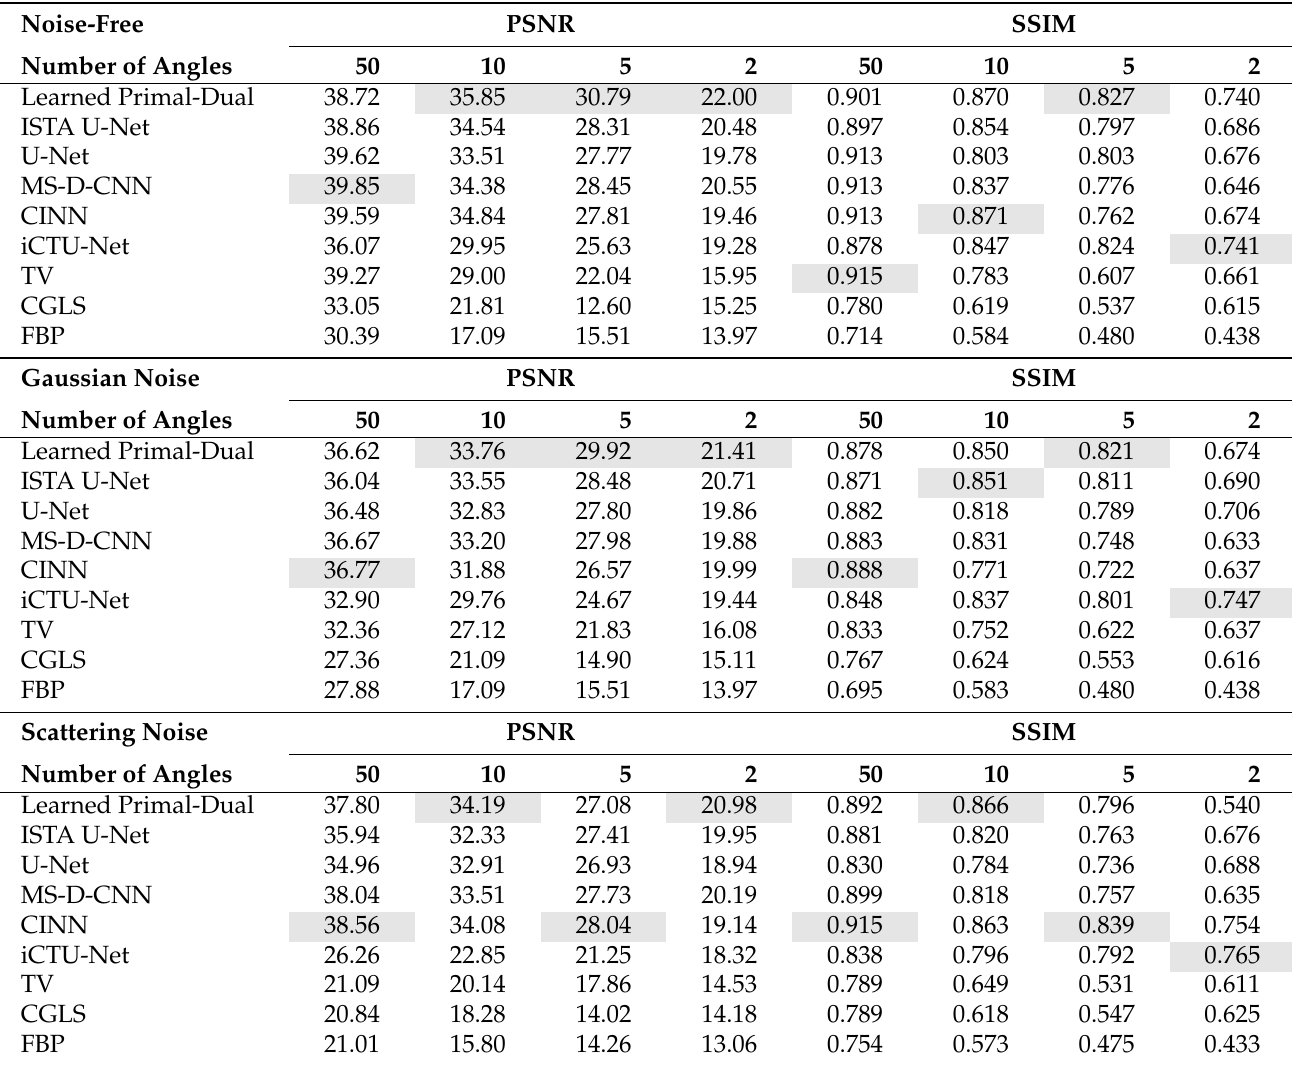
Table 4. Peak signal-to-noise ratio (PSNR) and structural similarity (SSIM) (adapted to the data range of each ground truth image) for the different noise settings on the Apple CT datasets. Best results are highlighted in gray. See Figures A7 and A8 for a